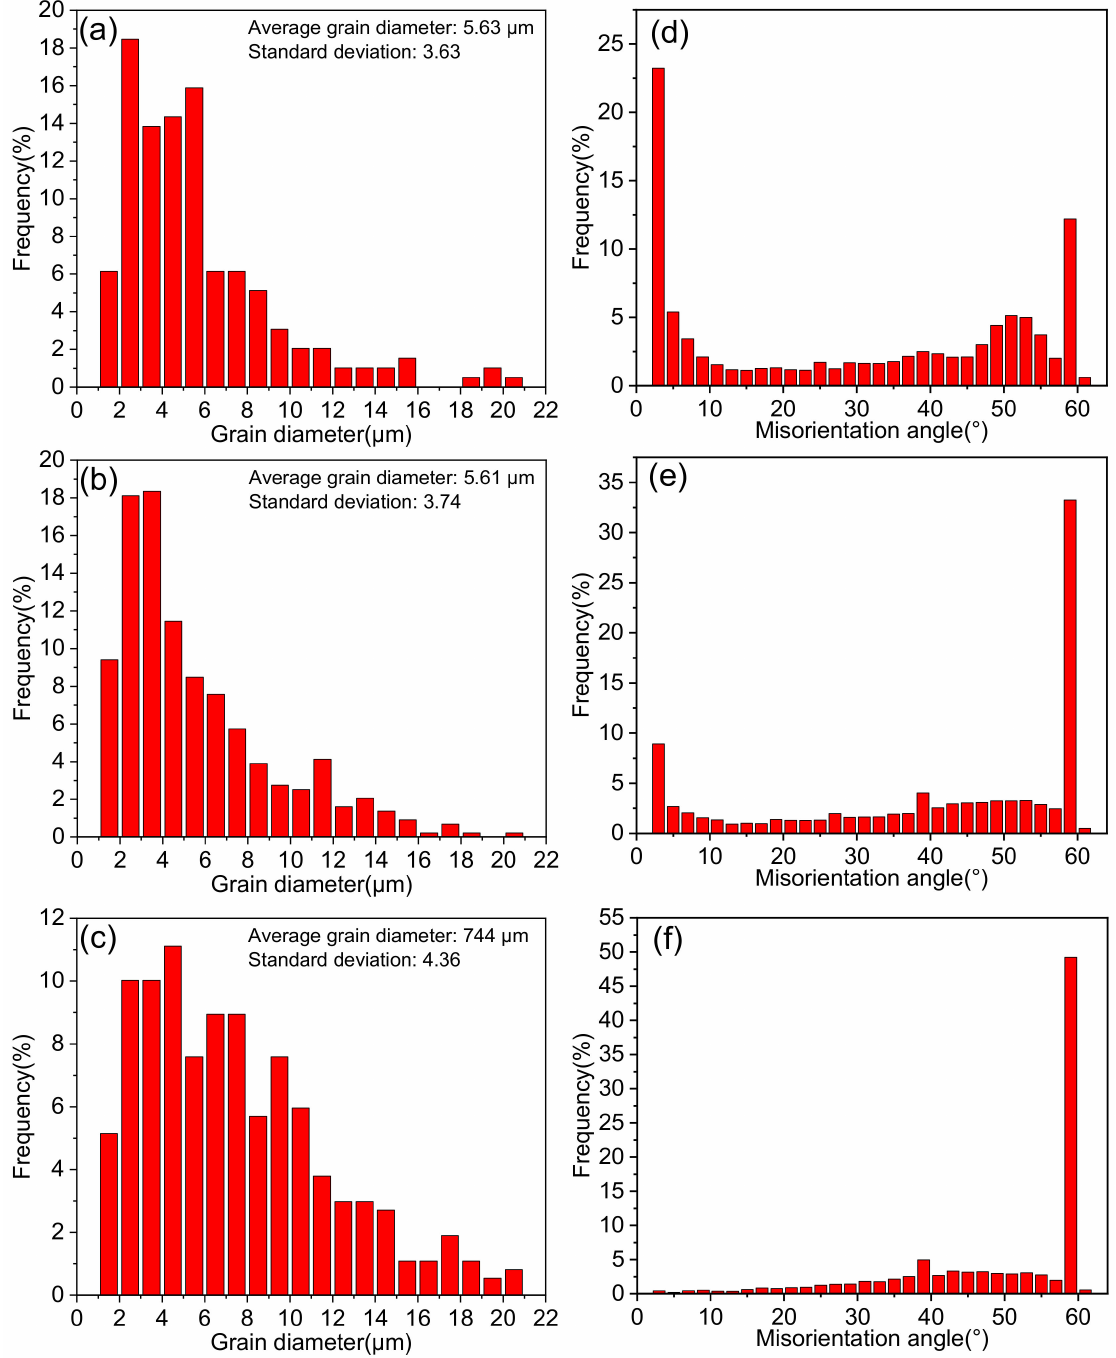
Figure 11. Grain sizes and misorientation angles under different strain rates: ( a , e ) 1000 ◦ C, 0.05 s − 1 , ( b , d ) 1000 ◦ C, 0.01 s − 1 , ( c , f ) 1000 ◦ C, 0.005 s − 1